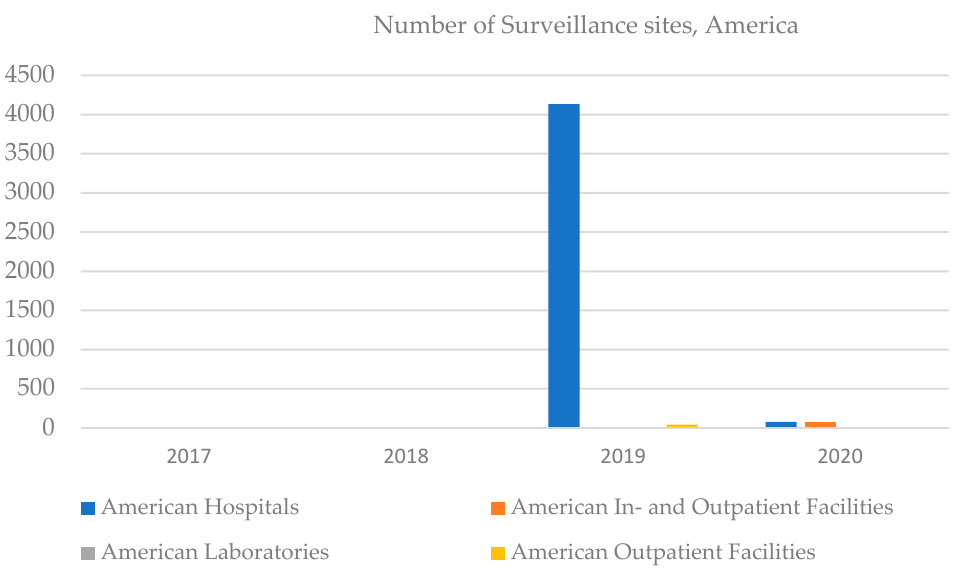
Figure 5. Number of surveillance sites, America, 2017–2020.